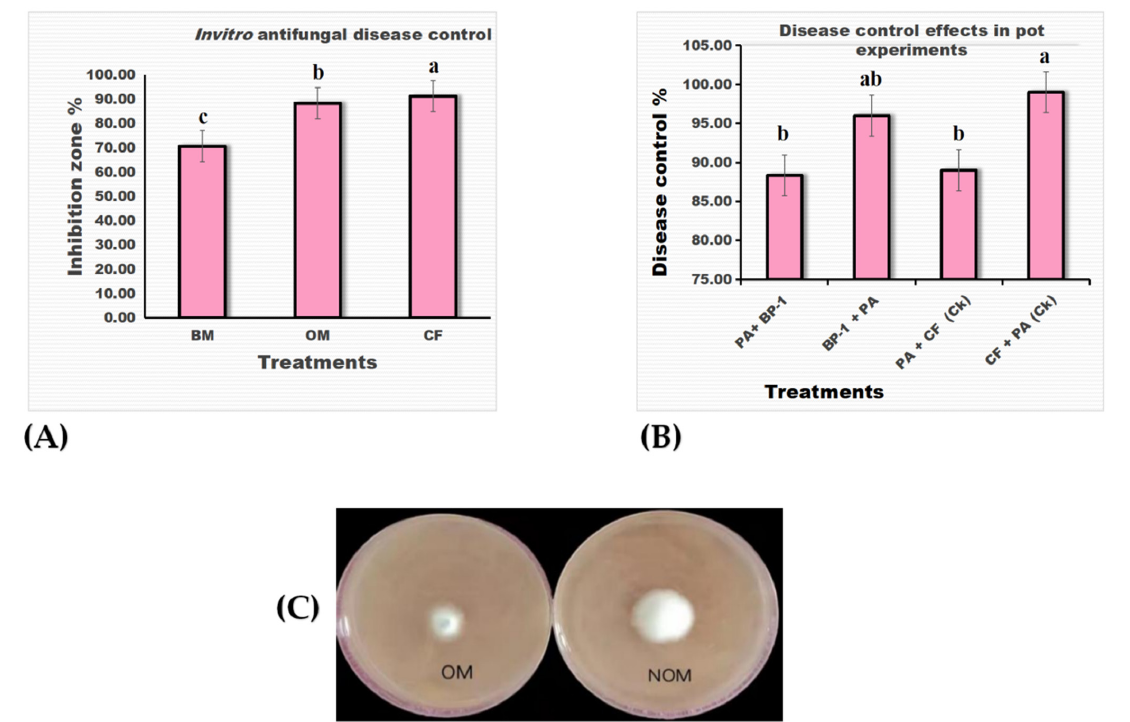
Figure 4. In vitro antagonistic activity of B. velezensis BP-1; ( A ) commercial fungicide (CF) was used as the control value. Optimized fermentation medium (OM) broth and basic medium (BM) broth; ( B ) disease control e ff ects in pot experiment: B. velezensis BP-1 (BP-1), commercial fungicide (CF), P.